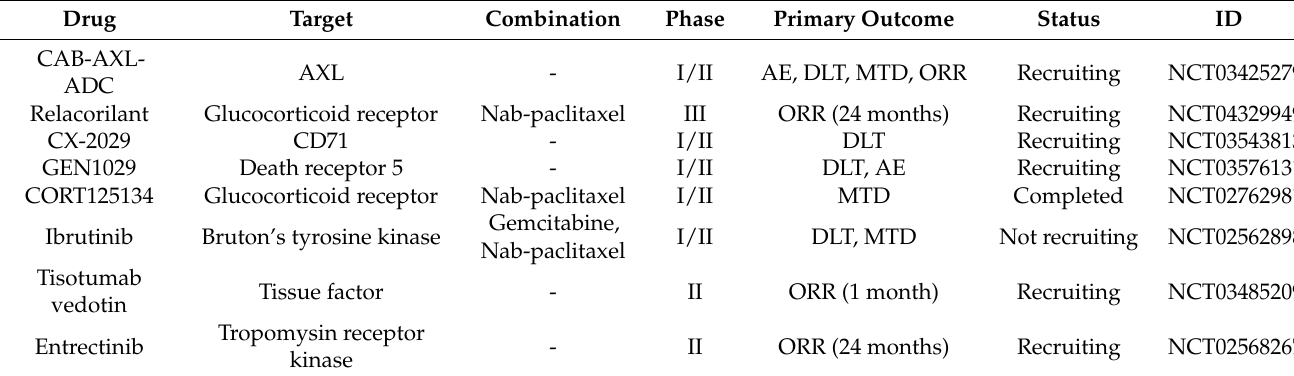
Table 3. Other receptors currently studied in clinical trials for the treatment of pancreatic